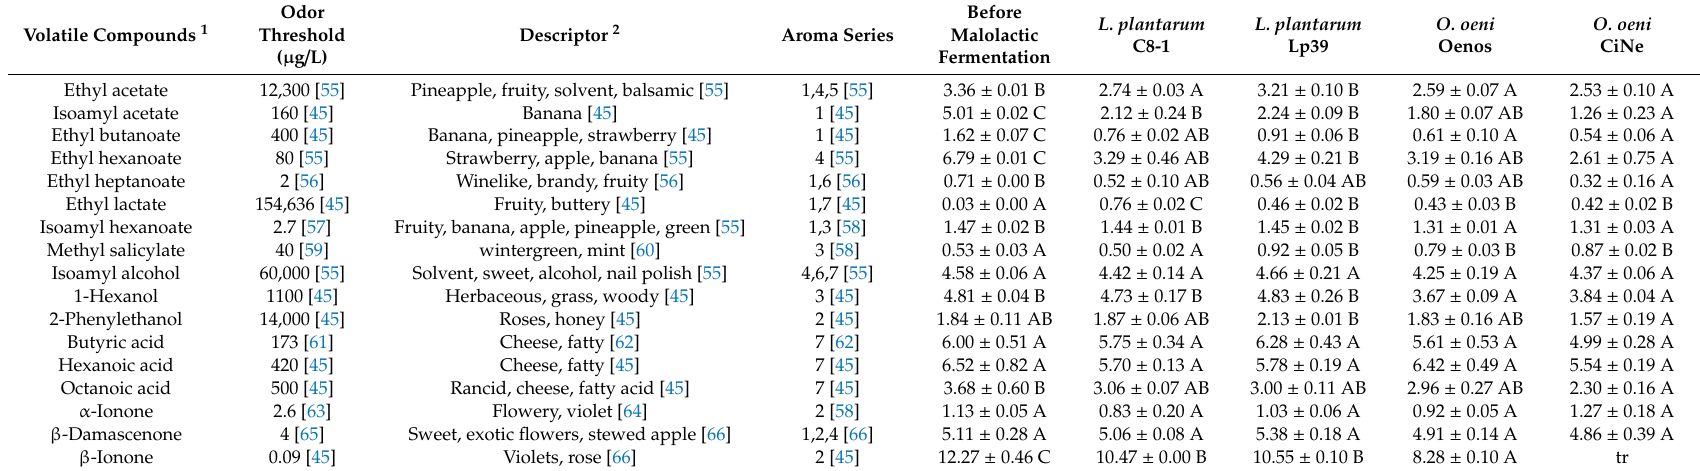
Table 4. Odor activity value of critical volatile compounds in Cabernet Gernischt wine before and after malolactic fermentation using L. plantarum (C8-1 and Lp39) and O. oeni (Oenos and